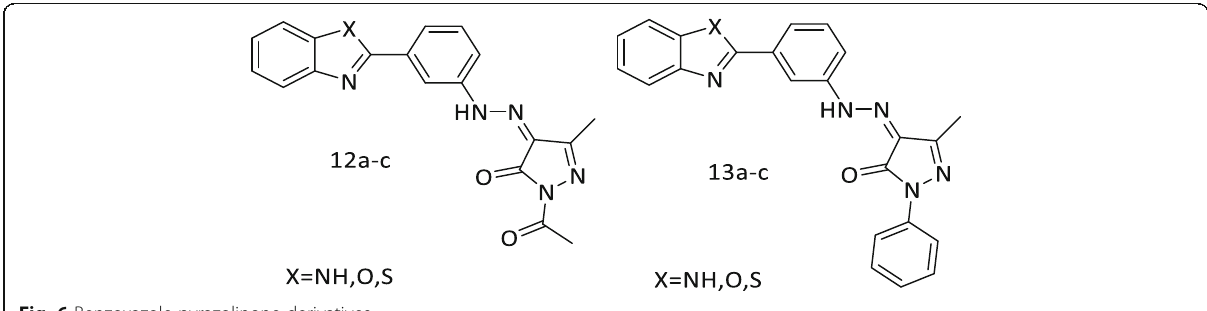
Fig. 6 Benzoxazole-pyrazolinone